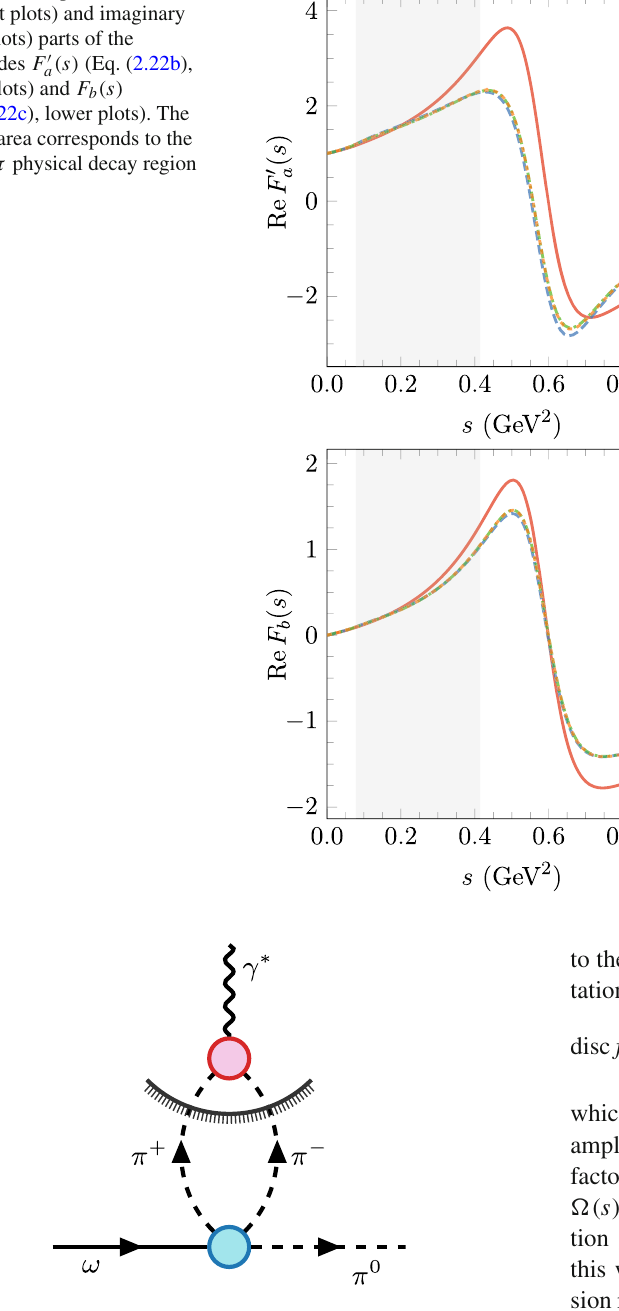
Fig. 2 Diagrammatic representation of the two-pion contribution to the discontinuity of the ωπ 0 transition form factor [cf. Eq.(2.27)]. The blue and red circles represent, respectively, the full s -channel P -wave ω → 3 π amplitude f ( s ) and the pion vector form factor F V 1